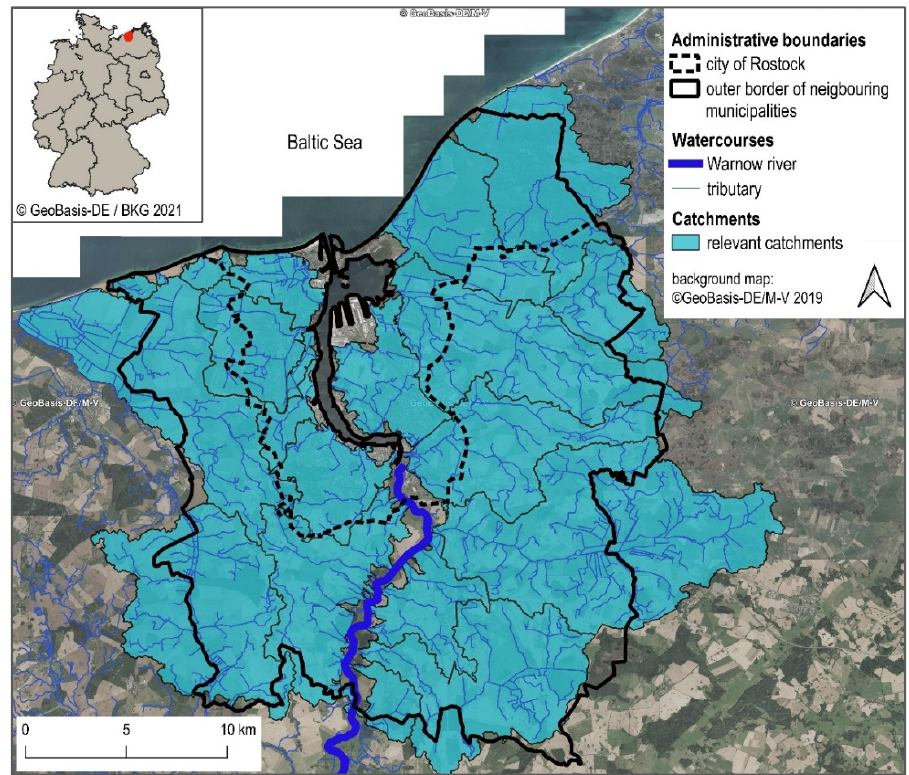
Figure 1. Relevant surface catchments of the study area and administrative boundaries. The history of the city of Rostock goes back to the 13th century. Since then, the city has grown not only in its territorial area but also in its population, reaching nearly 210.000 inhabitants today [23]. For Rostock, an increase of nearly 15.000 inhabitants is expected